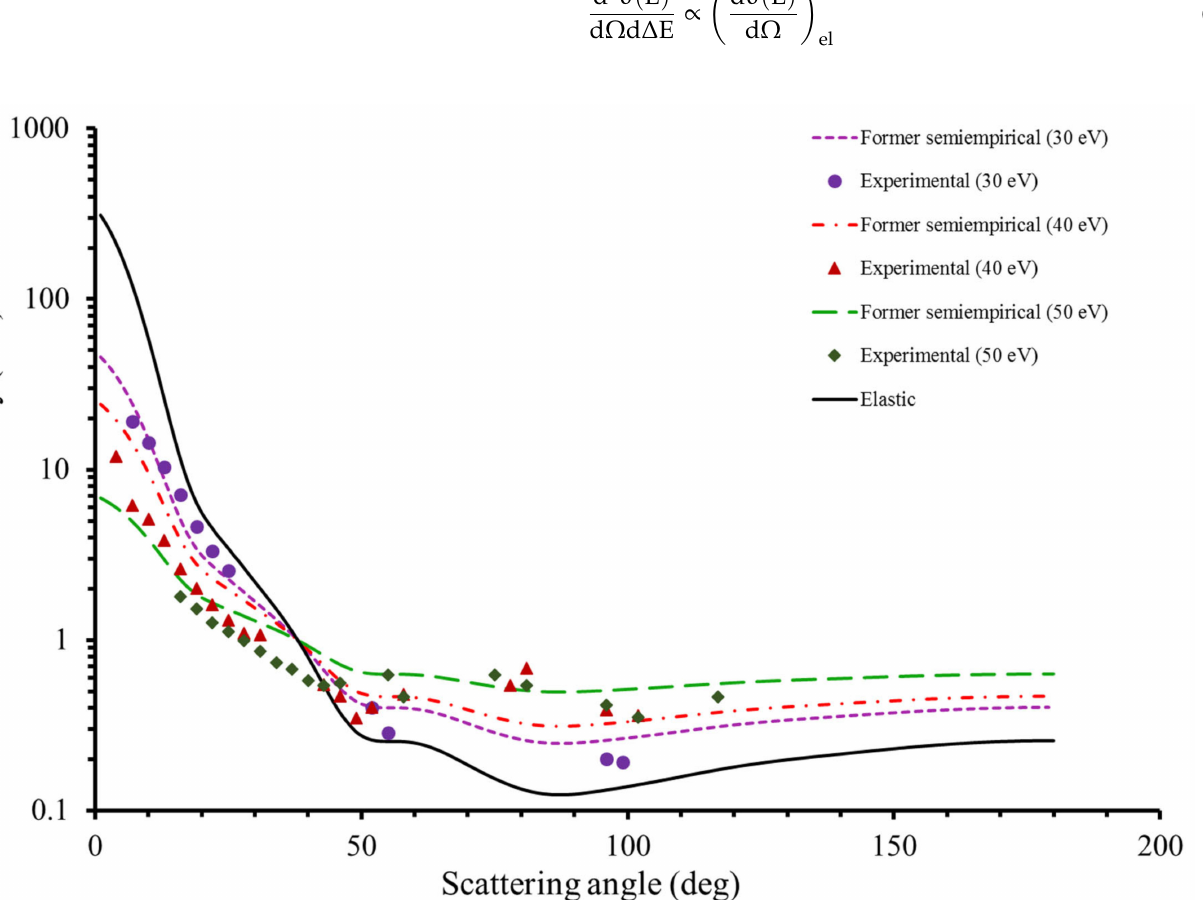
Figure 4. Inelastic angular distribution obtained from our former semi-empirical formula (Equation (1)) together with the experimental DDCS for transferred energies of 30, 40 and 50 eV and impact energy of 90 eV. Note that the elastic distribution is also